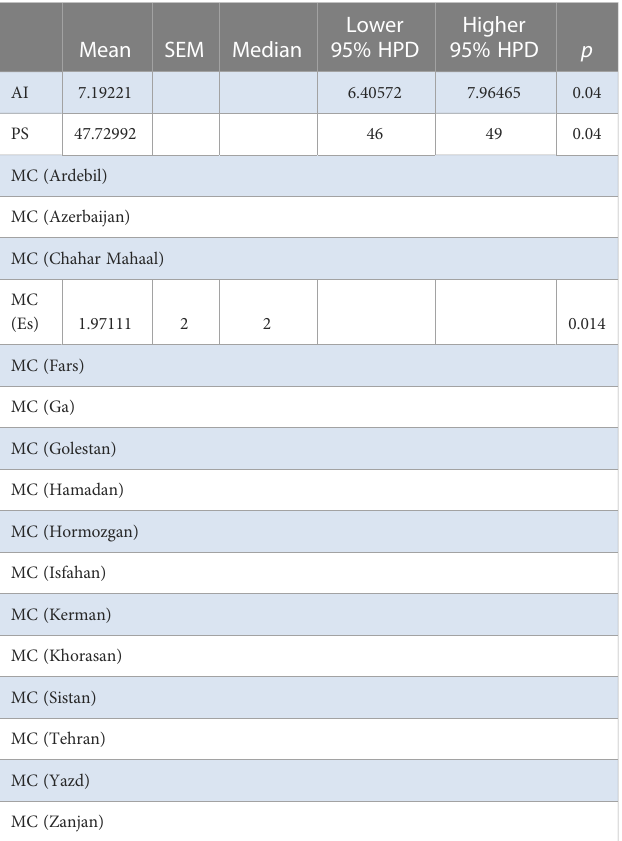
TABLE 9 BaTS algorithm analysis for the Iranian AMV population (provinces).